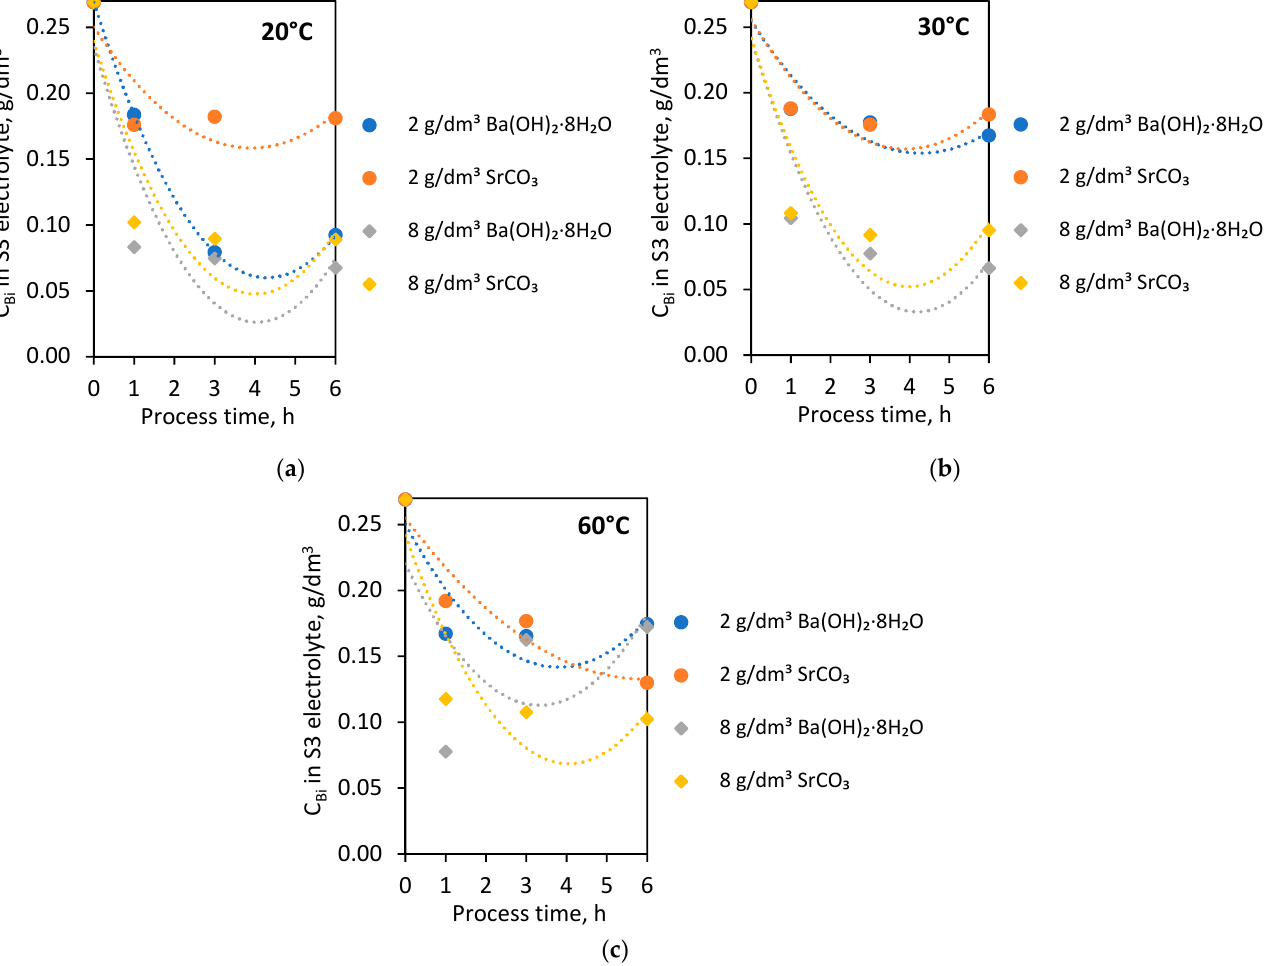
purification of the solution from the Bi impurity than in the case of 8 g/dm 3